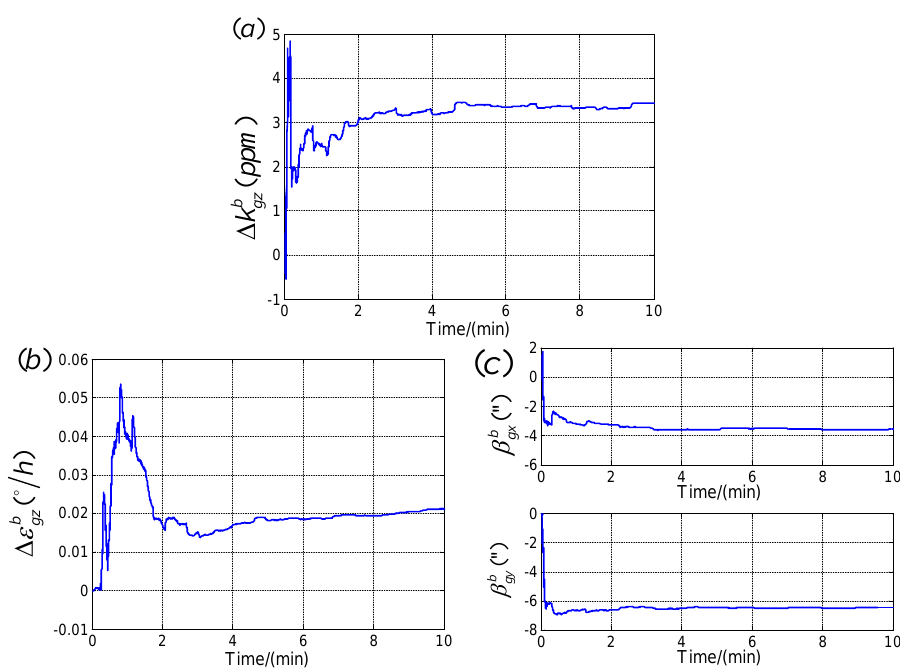
Figure 6. The curve convergences of the calibrated errors in the first step. ( a ) The curve convergences of ∆ k b gz ; ( b ) The curve convergences of ε b gz ; ( c ) The curve convergences of β b gx and β b gy .